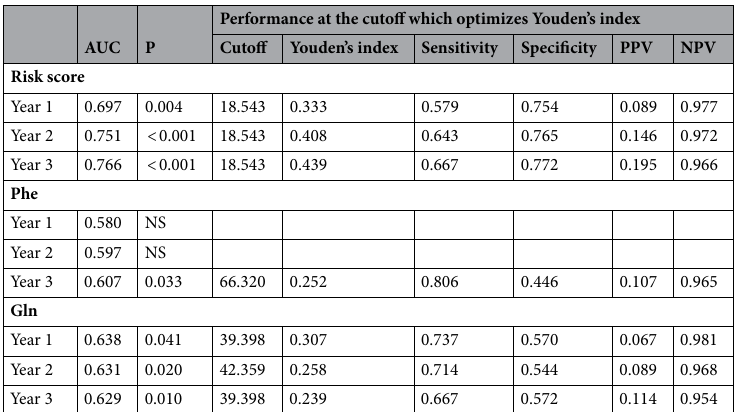
Performance at the cutoff which optimizes Youden’s index AUC P Cutoff Youden’s index Sensitivity Specificity PPV